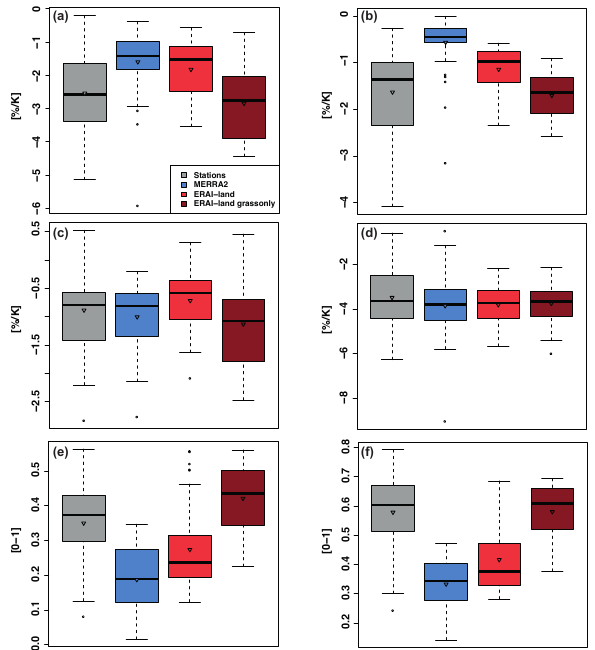
Figure 4. Box plot analysis for MAMJ 2000–2013: (a) SNC + TEM, (b) SNC, (c) TEM, (d) snowmelt sensitivity, (e) albedo contrast and (f) snow albedo. Triangle indicates the mean